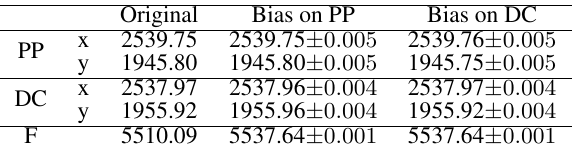
Table 2. Variation of primary camera calibration